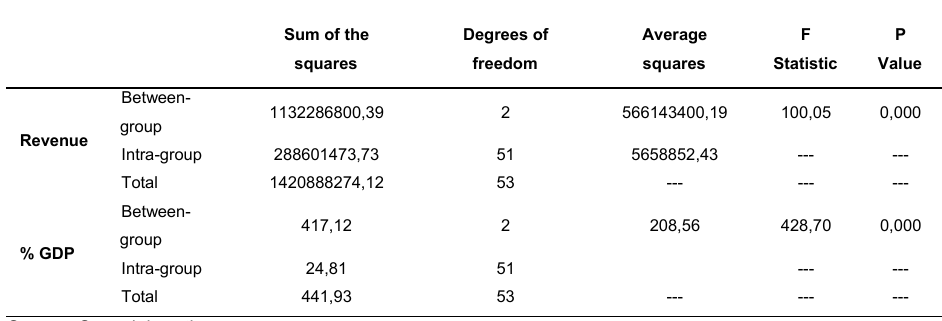
Table 2. ANOVA test results.